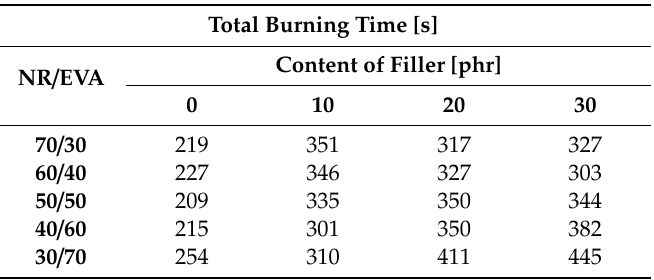
Table 3. The flammability of